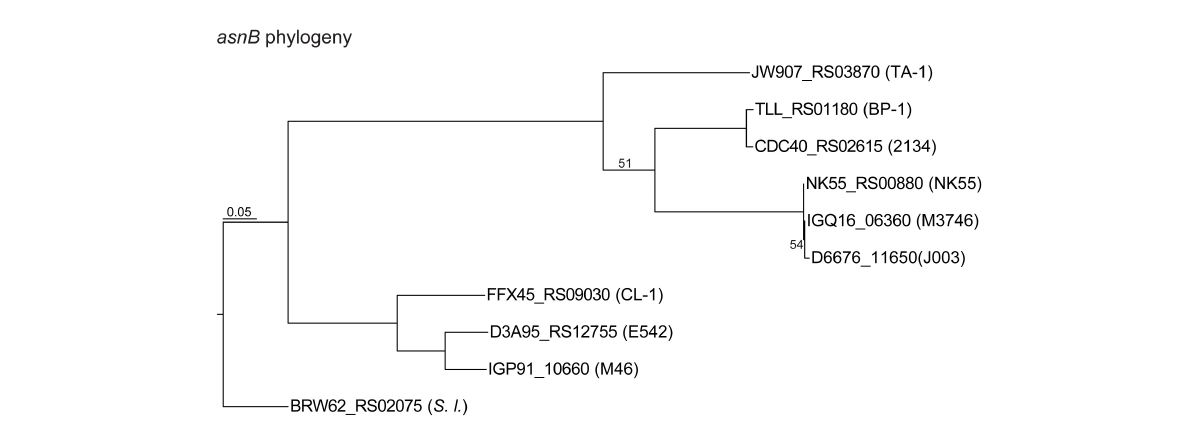
FIGURE6 Maximum likelihood phylogeny of the asparagine synthetase gene ( asnB ) homologs. The homologs are labeled with the locus tags; strain name abbreviations are in